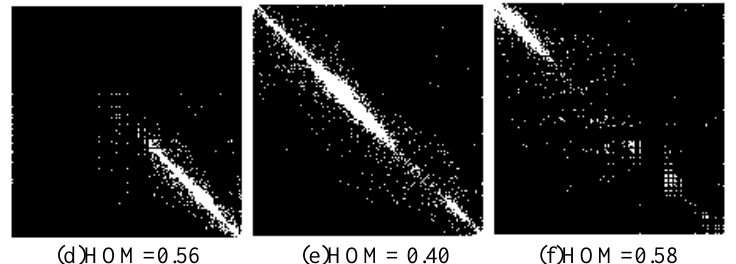
Figure 3. Three images with different gamma condition and their associated co-occurrence matrix with extracted homogeneity